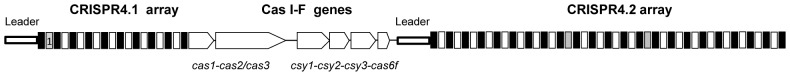
Graphical representation of the CRISPR-Cas I-F locus of E. coli strain LF82.Spacers with and without identified protospacers as well as repeats are represented as gray, white and black rectangles respectively. Spacer #1 is labeled. Cas genes are shown as boxes pointing towards the direction of transcription.